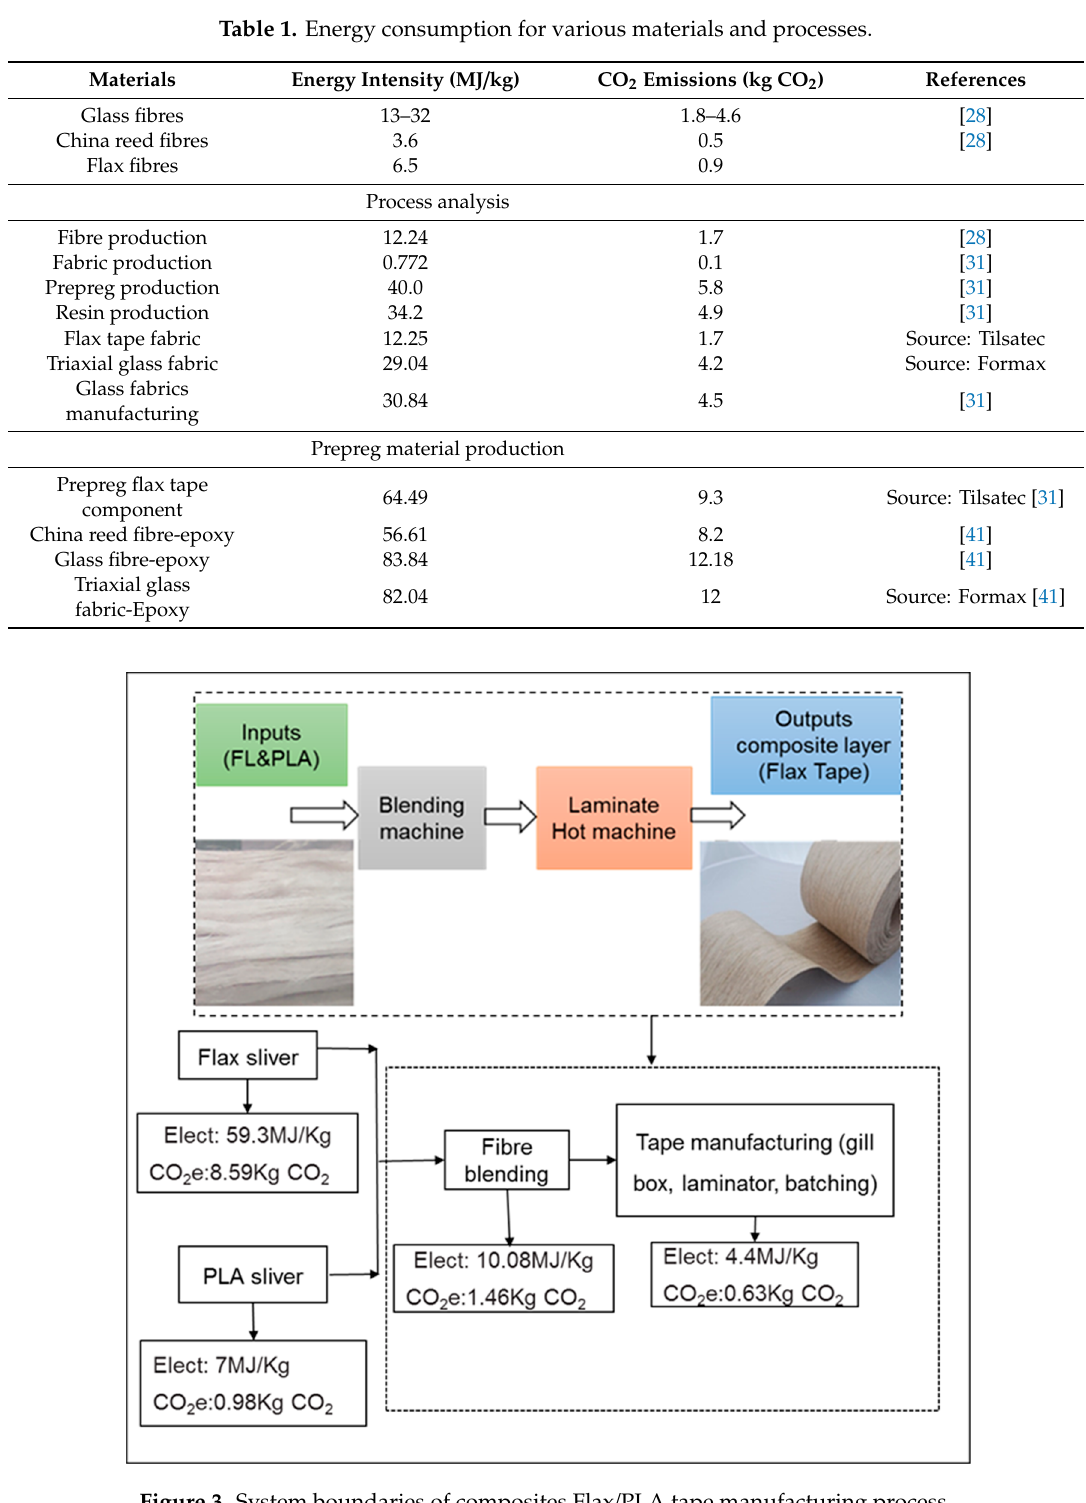
Figure 3. System boundaries of composites Flax/PLA tape manufacturing process .